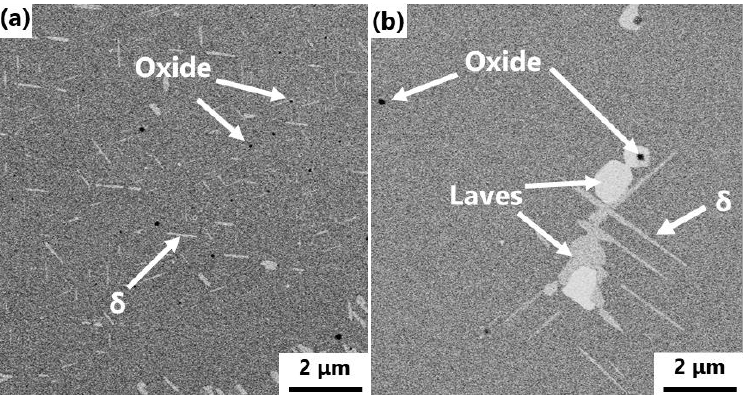
Figure 6. BSE (backscatter detector) images of HT specimens: ( a ) Ar-SLM, and ( b ) V-SLM